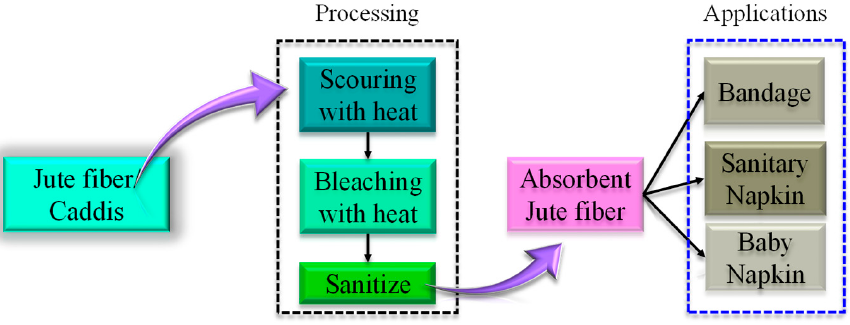
Figure 25. Jute fiber converted into an absorbent cotton-like product for medical accessories and personal hygiene